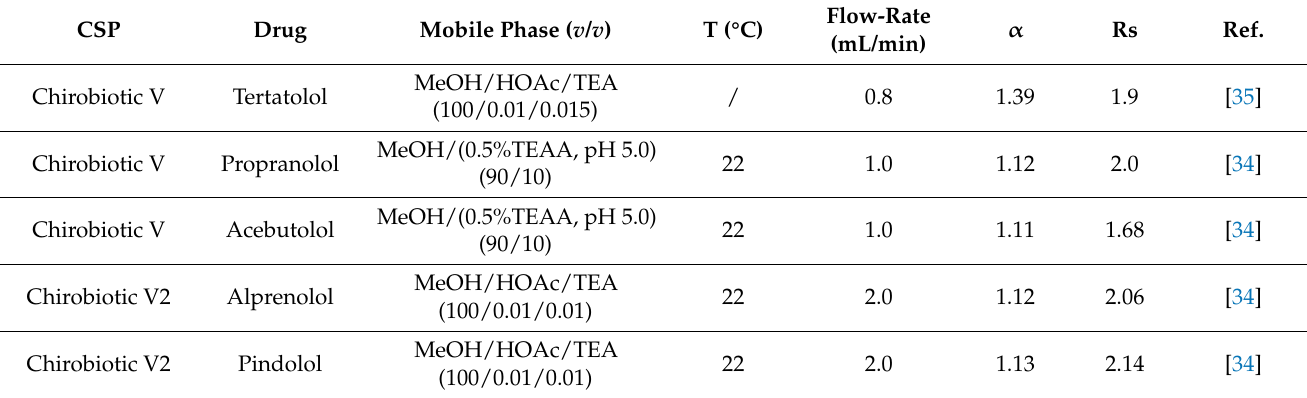
Table 6. Typical results for the enantioseparation of β -blockers on Chirobiotic V and Chirobiotic V2. CSP Drug Mobile Phase ( v / v